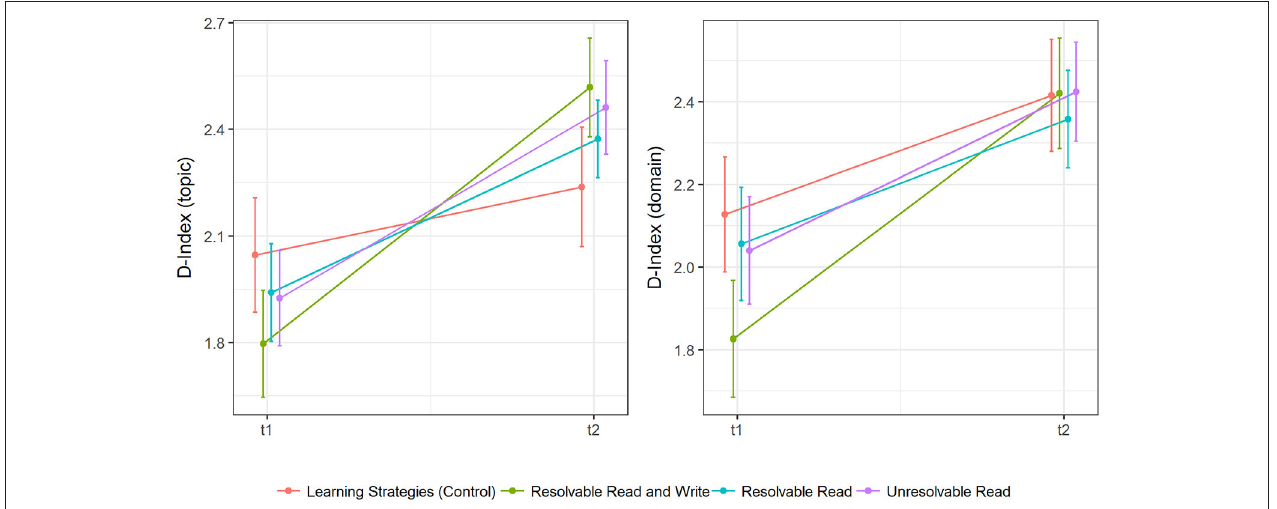
FIGURE 5 | Descriptive differences (means and standard errors) in epistemic change in topic-specific (FREE-GST) and domain-specific epistemic beliefs (FREE-EDPSY) for the D-index.